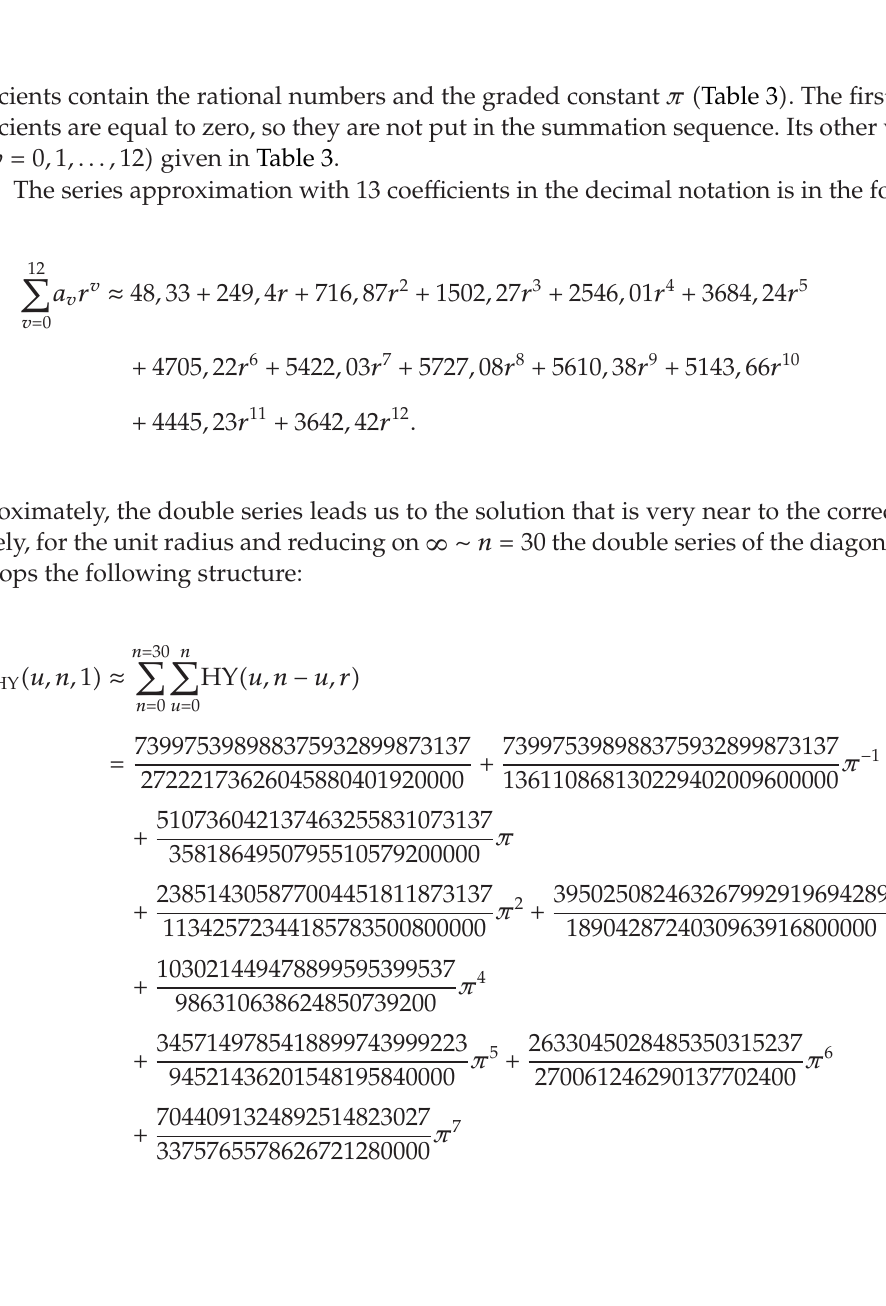
Figure 3: The representative submatrix (cid:2) above (cid:3) and the addition principle of the matrix members on the